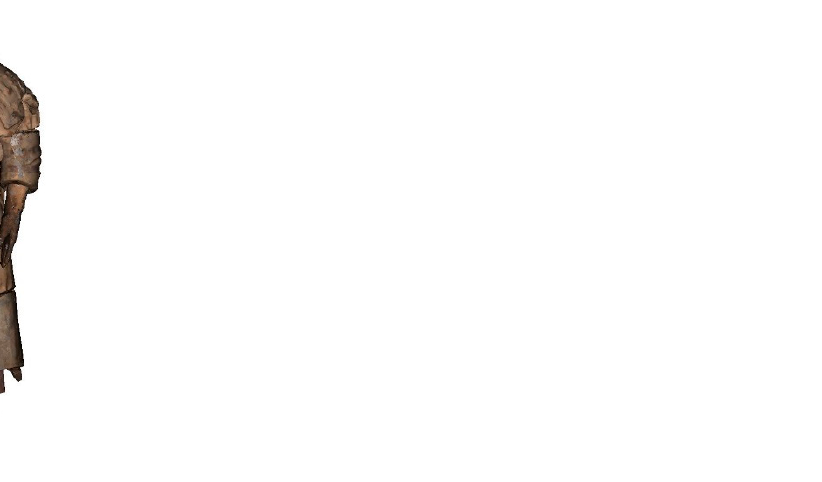
Figure 16. Reassembling result of an entire Terracotta warrior (the head and feet can no longer be found; they may have been devastated).